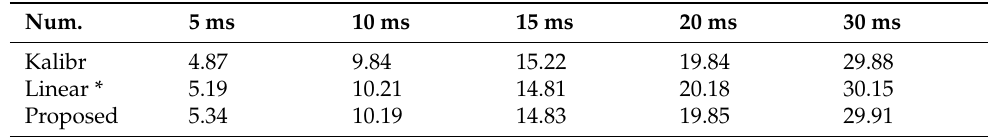
Table 2. IMU and lidar time offset calibration